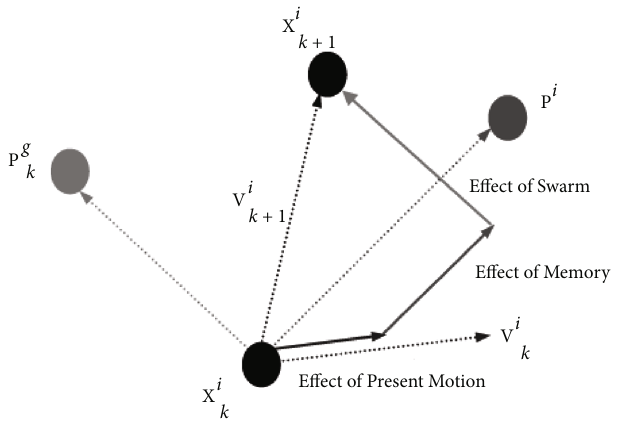
Figure 5: Velocities and positions in